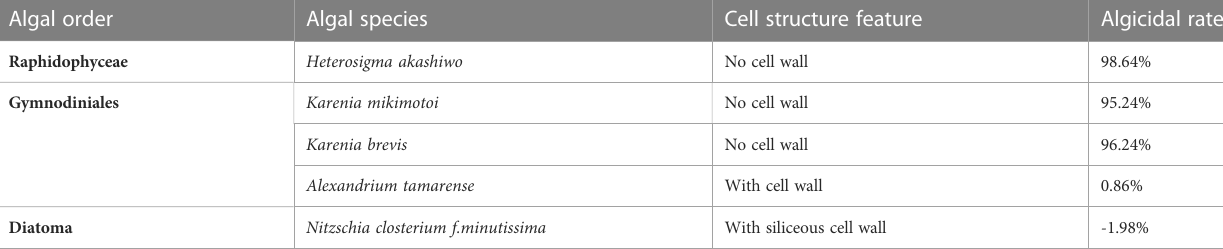
TABLE 2 Inhibition of different typical red tide organisms by the algicidal substances of B.laterosporus . Algal